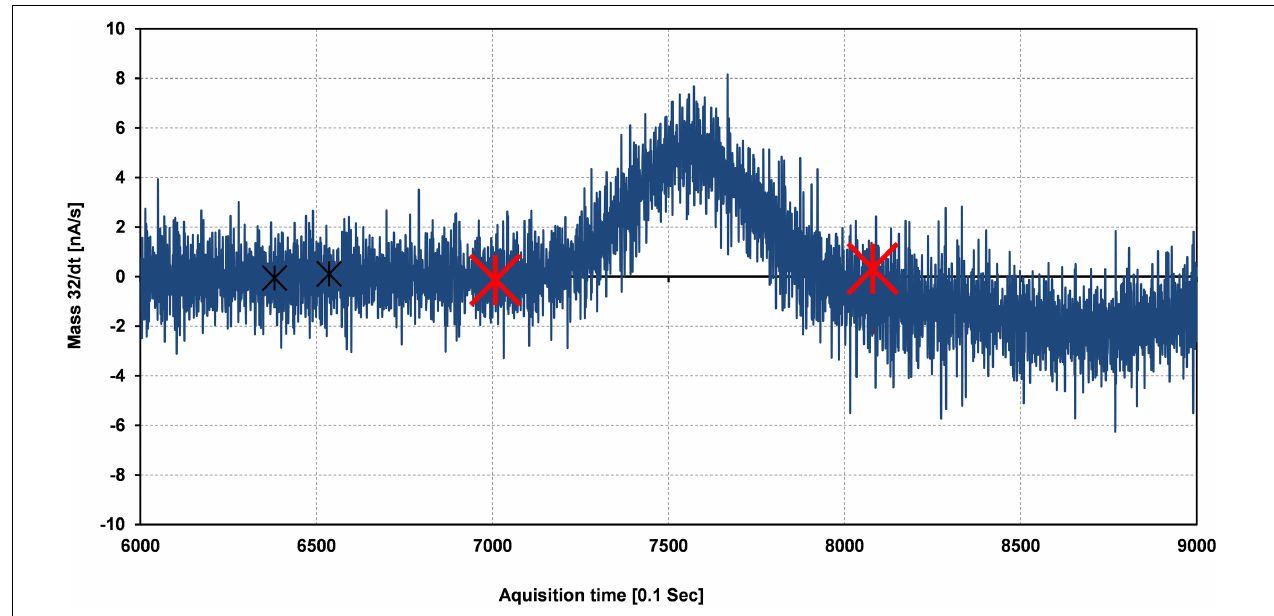
FIGURE 3 | Calculation of the delta ( δ 17 O, δ 18 O) value for the sample signal is taken in between the range of the two red crosses while for the background calculation (black crosses) for better precision based on the time derivative of the mass/charge ratio [d(m/z)/dt].